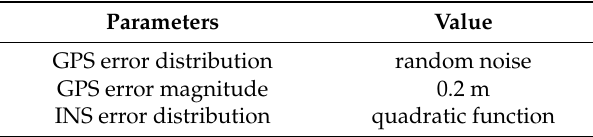
Table 3. Simulation parameters of positioning error.